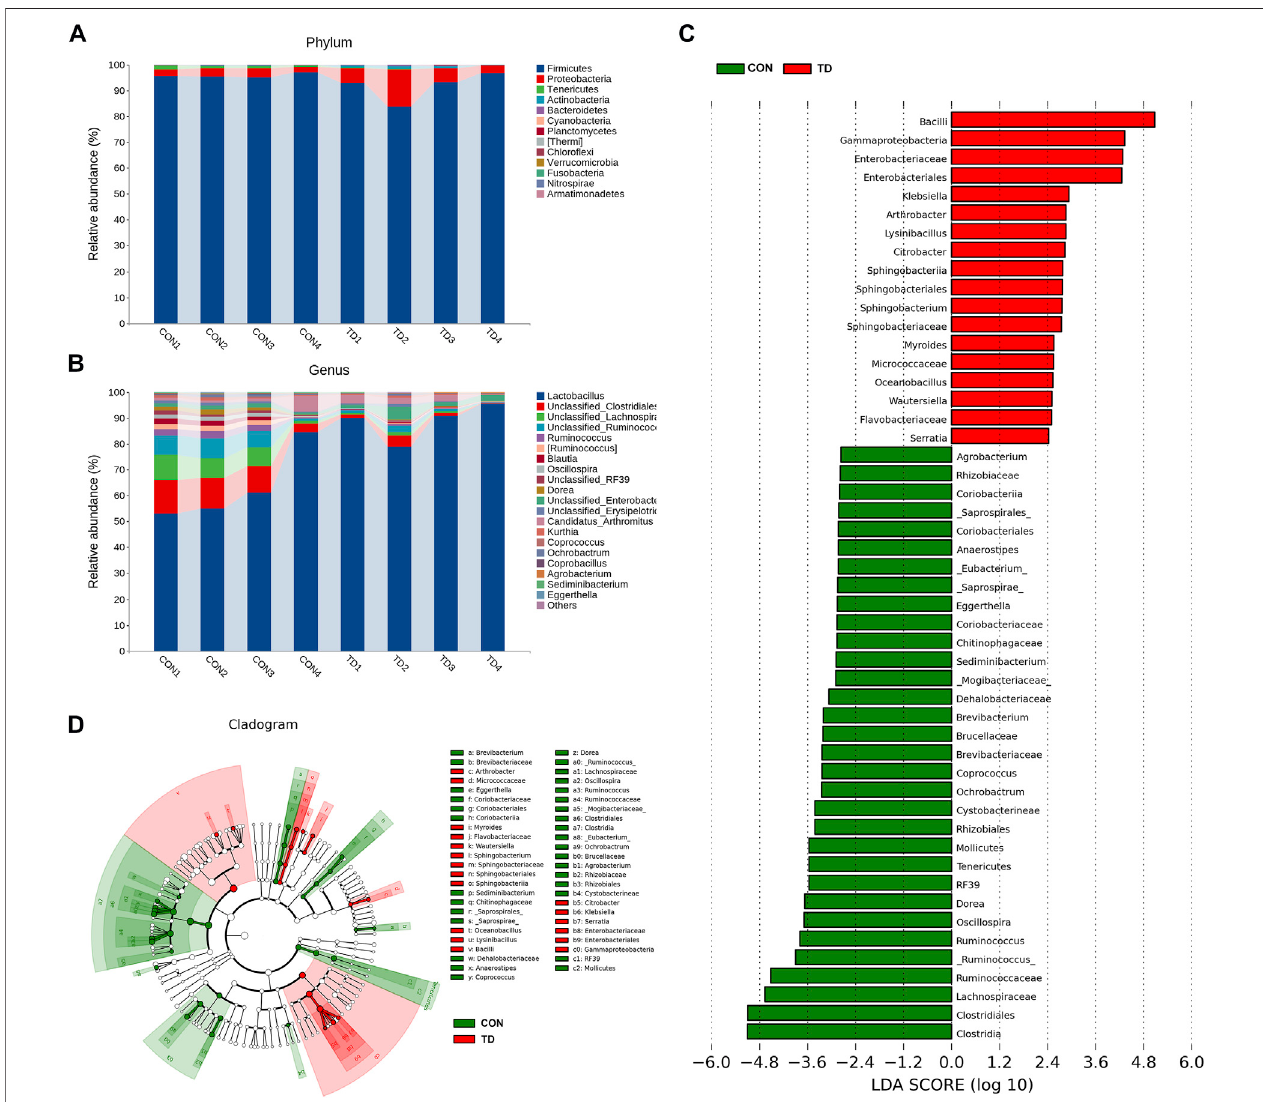
FIGURE3| Fecalmicrobialcompositionofbroilerchickens. (A,B) Relativeabundanceofmicrobiotaatthephylumlevelandthegenuslevel(Top20)inCONandTD groups. (C,D) LDA score and cladogram of LDA effect size (LEfSe) comparison analysis between the CON and TD groups. As indicated, the red, green shading representsbacterialtaxathatweresigni fi cantlyhigherineithertheCONorTDgroup.TheselectionofdiscriminativetaxabetweentheCONandTDgroupswasbasedon anLDAscorecutoffof2.0,anddifferencesintherelativeabundancesoftaxawerestatisticallydetermined basedonaWilcoxon ’ ssigned-ranktestatasigni fi cance level of 0.05 (N =